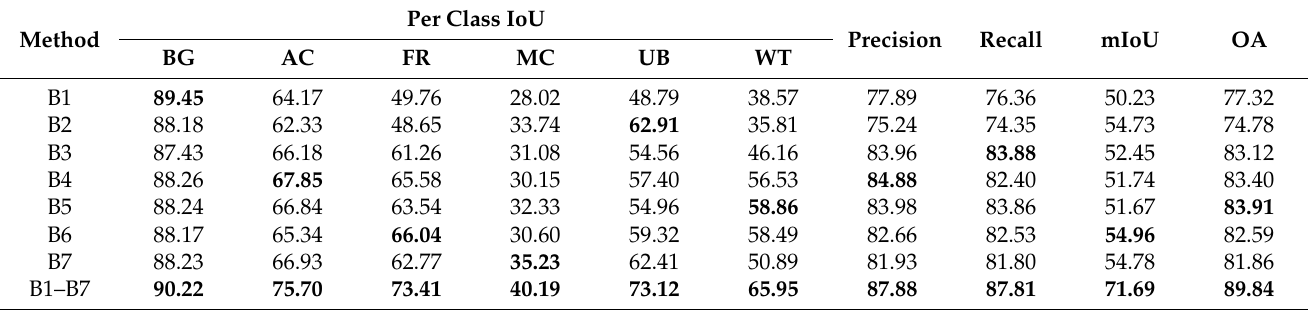
Table 4. The accuracy result (%) of spectral bands on the land use